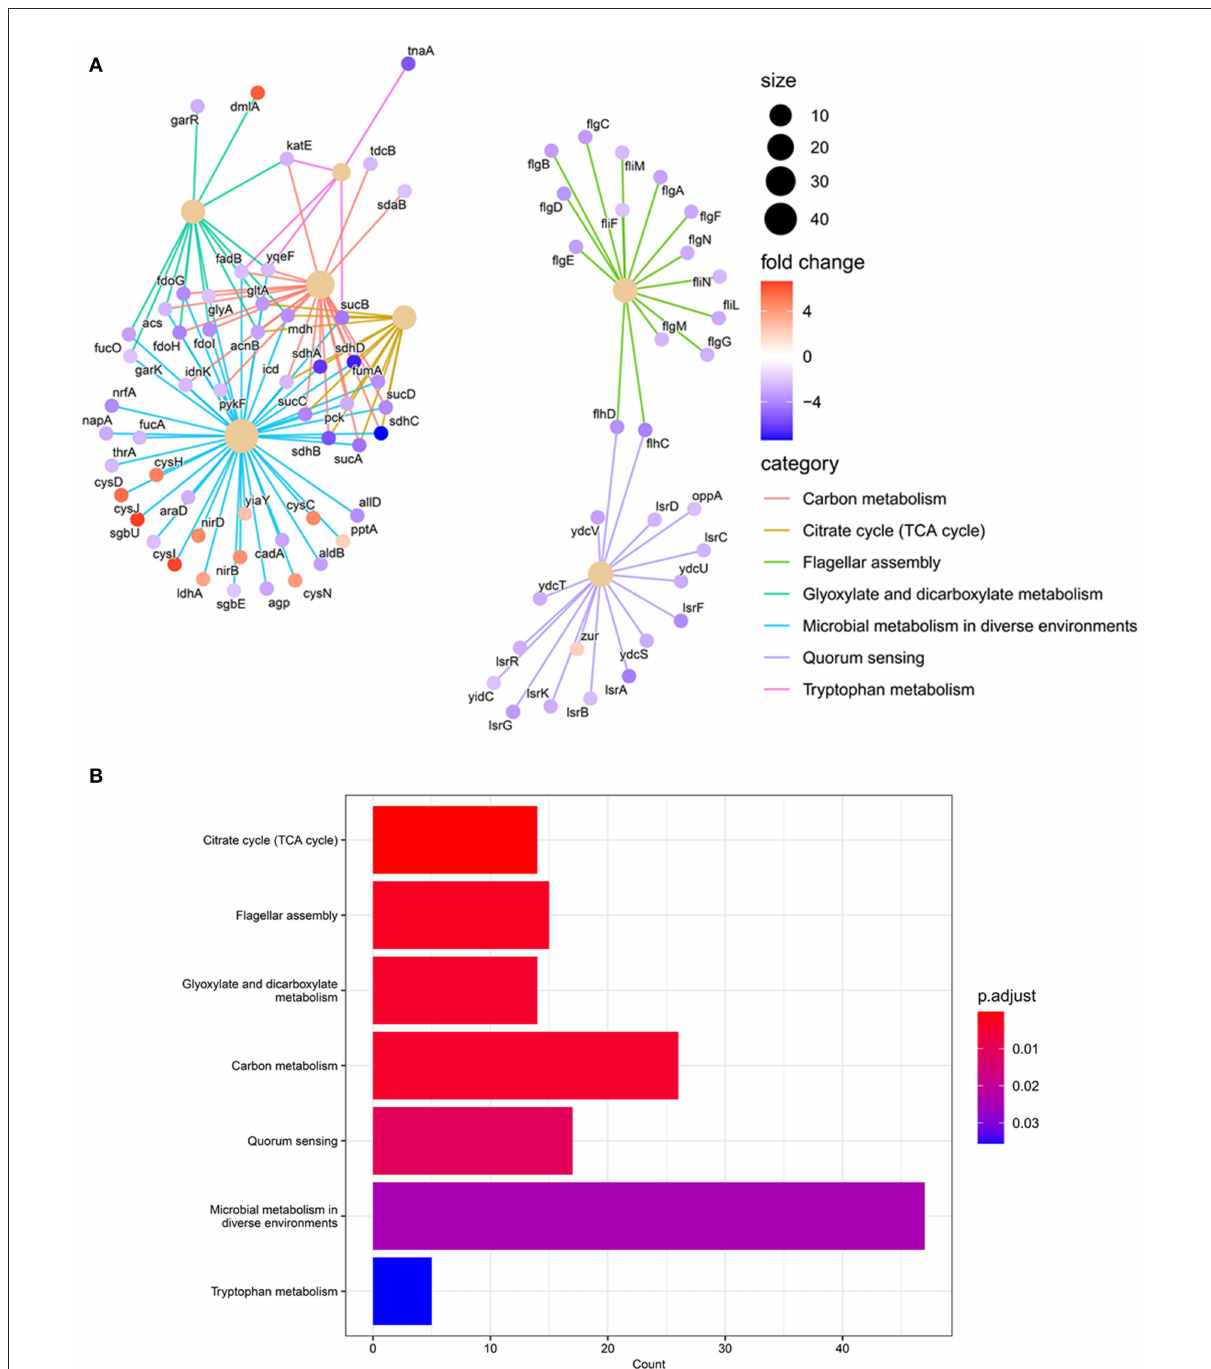
FIGURE4 Gene annotation enrichment analysis of KEGG pathway. (A) Differentially expressed genes (DEGs) and KEGG pathway enrichment analysis in 4 µ g/mL AXO + 4 mg/mL CRAN (CC) compared to control. The blue circle indicates downregulation, while the red circle indicates upregulation. The darker the color, the stronger the effect. These are combined from 10 different pathways, with none of the pathways providing more than three interactions. (B) Count of affected genes in each KEGG pathway. A log 2 -fold change of > 2 and false discovery rate (FDR) cutoffs ≤ 0.001 are